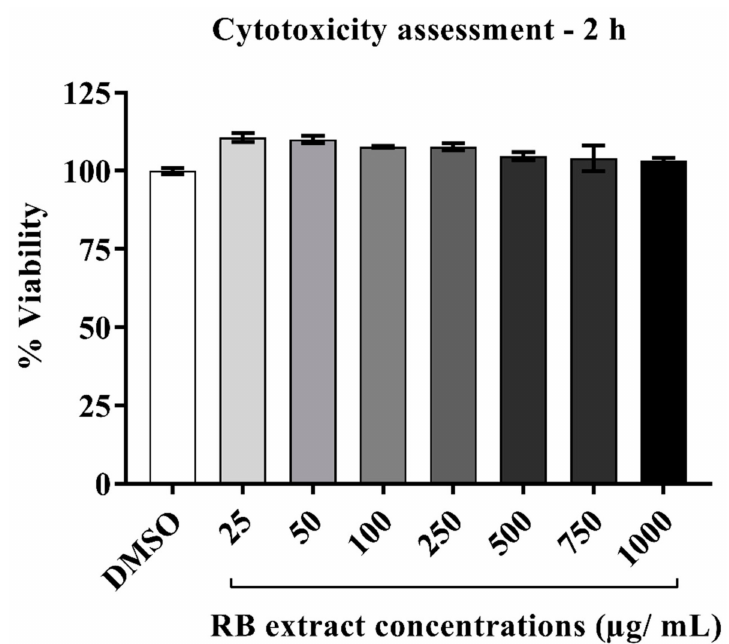
Figure 1. Cytotoxicity results in HUVECs after 2 h post-exposure to di ff erent concentrations of RB phenolic extracts. The RB phenolic extracts did not display any cytotoxic e ff ect on the HUVEC cells at any of the concentrations tested (25–1000 µ g / mL) ( n = 3). Data is presented as mean ± SEM. Dimethyl sulfoxide, DMSO; human umbilical vein endothelial cells, HUVEC; rice bran, RB. 2.2. E ff ect of RB Phenolic Extracts on Antioxidant Genes under Oxidative Stress Conditions The influence of RB phenolic extracts on antioxidant genes in HUVECs (Figure 2) under oxidative stress conditions displayed a significant increase ( p < 0.05) in the expression of Nrf2 and NQO1 genes was observed with pre-treatment at 100 and 250 µ g / mL of RB phenolic extracts when compared to the H 2 O 2 only treated group. The expression of HO1 gene was significantly increased when pre-treated with 250 µ g / mL of RB phenolic extracts. In the NOX4 gene, a significant reduction in expression ( p < 0.001) was observed at the highest RB phenolic concentration of 250 µ g /